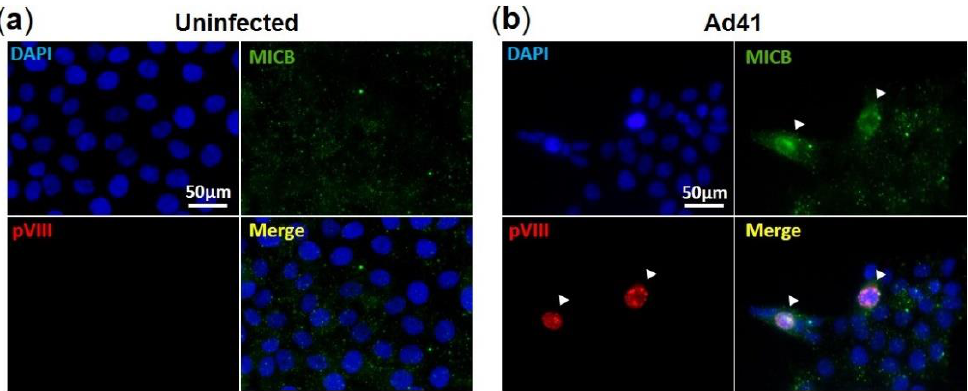
Figure 5. Immunofluorescence assay of MIC B in HAdV-F41-infected HCT116 cells. IF assay show- ing ( a ) uninfected and ( b ) HAdV-F41-infected HCT116 cells (MOI 0.5; day 2). HAdV-F41 was traced using a rabbit polyclonal anti-pVIII Ab and a secondary goat anti-rabbit-Rhodamine. MIC B detection was performed using a mouse anti-MIC B Ab followed by incubation with a goat anti-mouse-FITC. Cell nuclei were counterstained with DAPI. Arrows show HAdV-F41-infected cells exhibiting stronger signals of MIC B compared to uninfected cells.